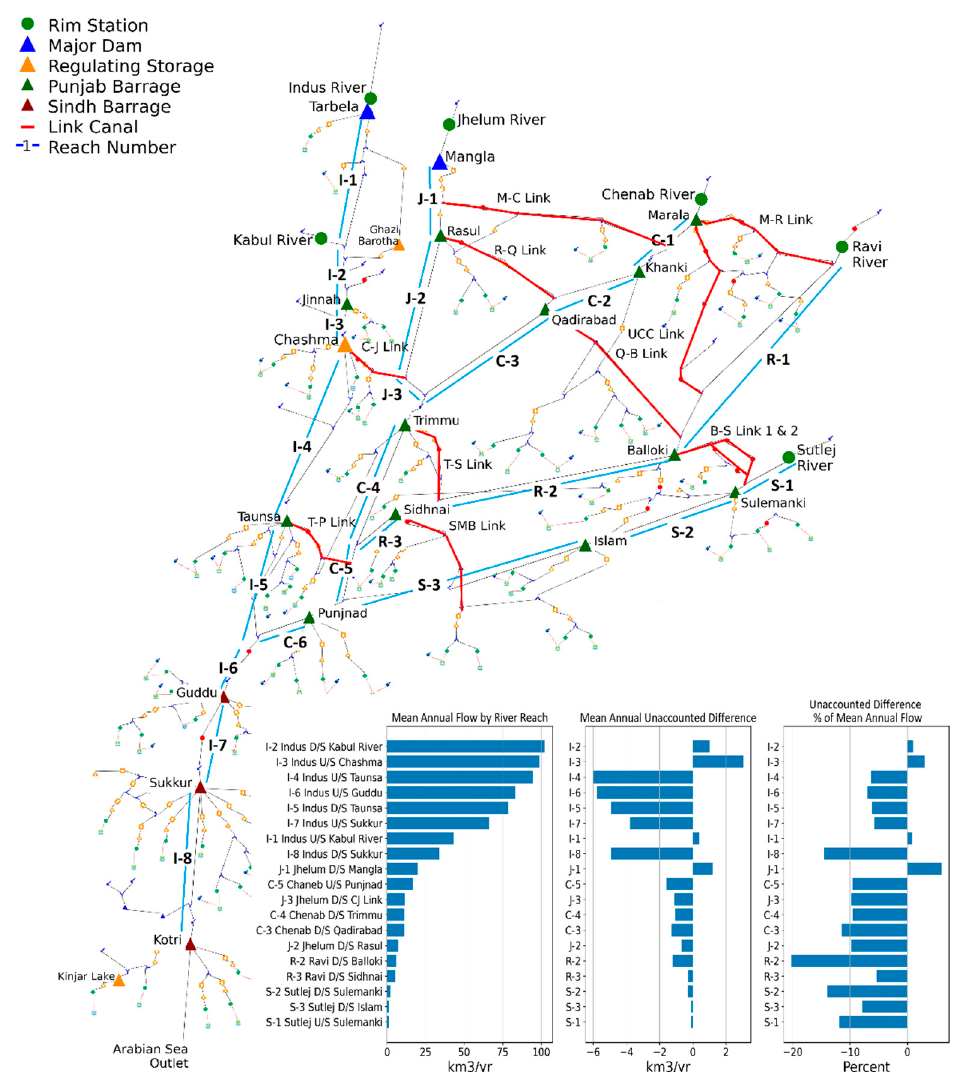
Figure 6. IRSM reach-based flows and proportion of modelled unaccounted differences. Numbering shows river reaches modelled with routing. Inset figure shows river reaches with routing and associated estimated unaccounted differences.